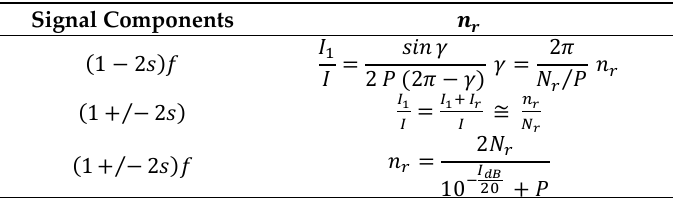
Table 13. Quantitative methods for detecting rotor